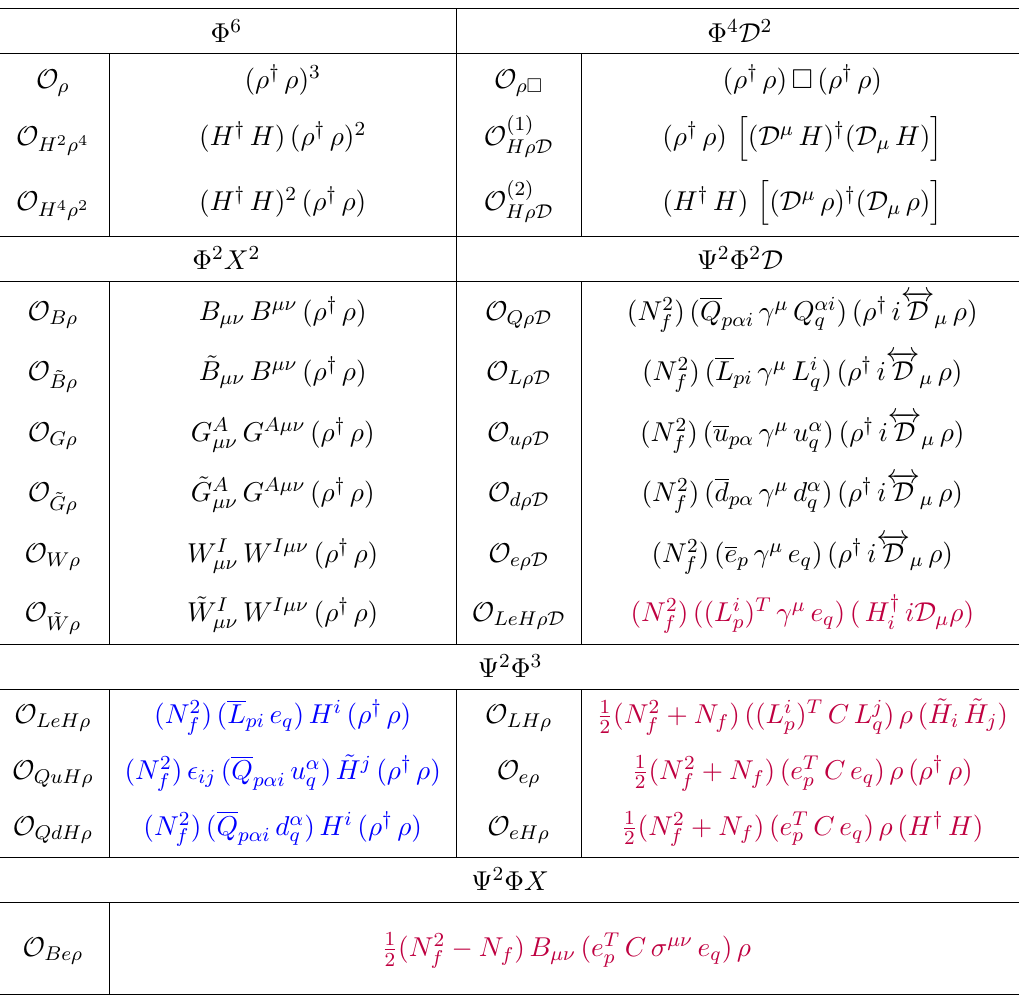
Table 5 . SM extended by Doubly Charged Scalar ( ρ ): additional operators of dimension 6. Boxed operators vanish for single flavour. ρ , ρ † represent ρ ++ and ρ −− respectively. Here i, j and α are the SU(2) and SU(3) indices respectively. A = 1 , 2 , · · · , 8 and I = 1 , 2 , 3 . p, q = 1 , 2 , · · · , N f are the flavour indices. Operators in red violate lepton